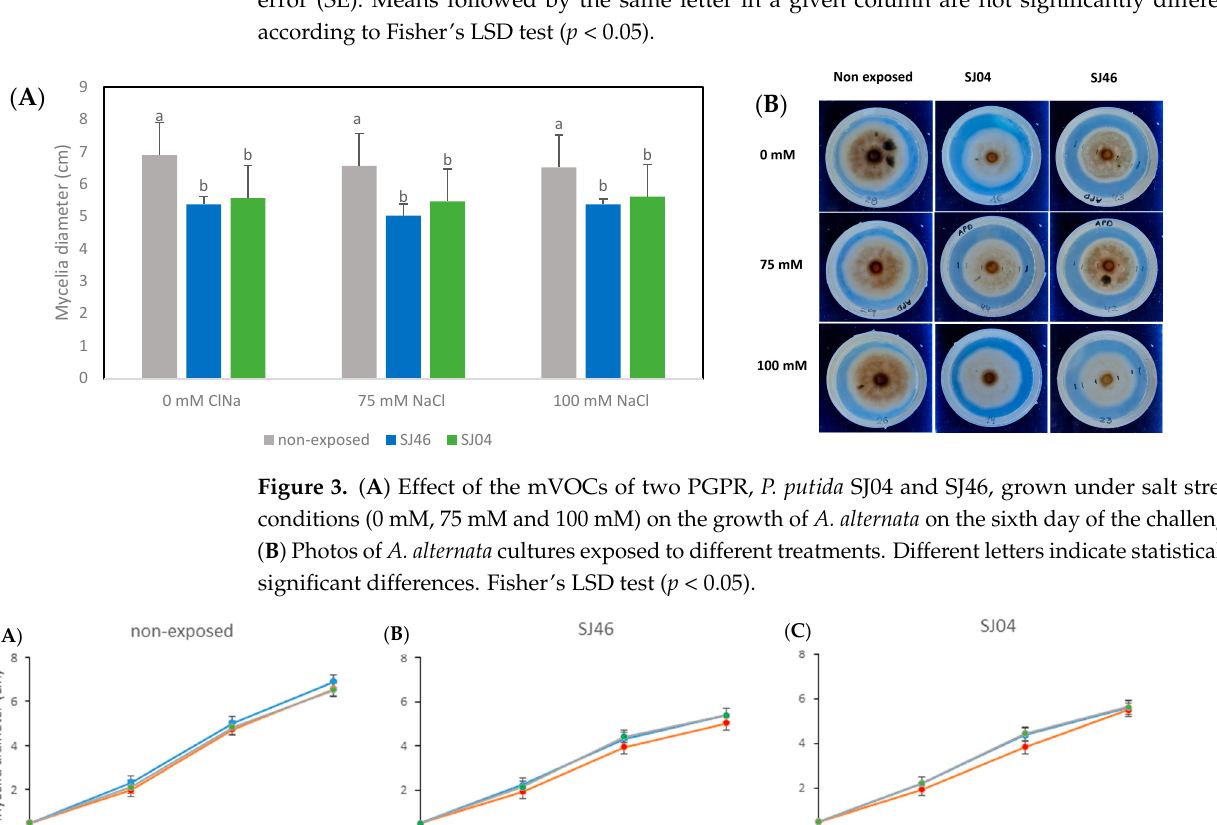
Figure 2. E ff ects of exposure to SJ46 and SJ04 mVOCs of P. putida on root dry weight of M. piperita plants grown in Murashige–Skoog medium with 0, 75 and 100 mM NaCl. Values are mean ± stand- ard error (SE). Means followed by the same le tt er in a given column are not signi fi cantly di ff erent according to Fisher’s LSD test ( p < 0.05).